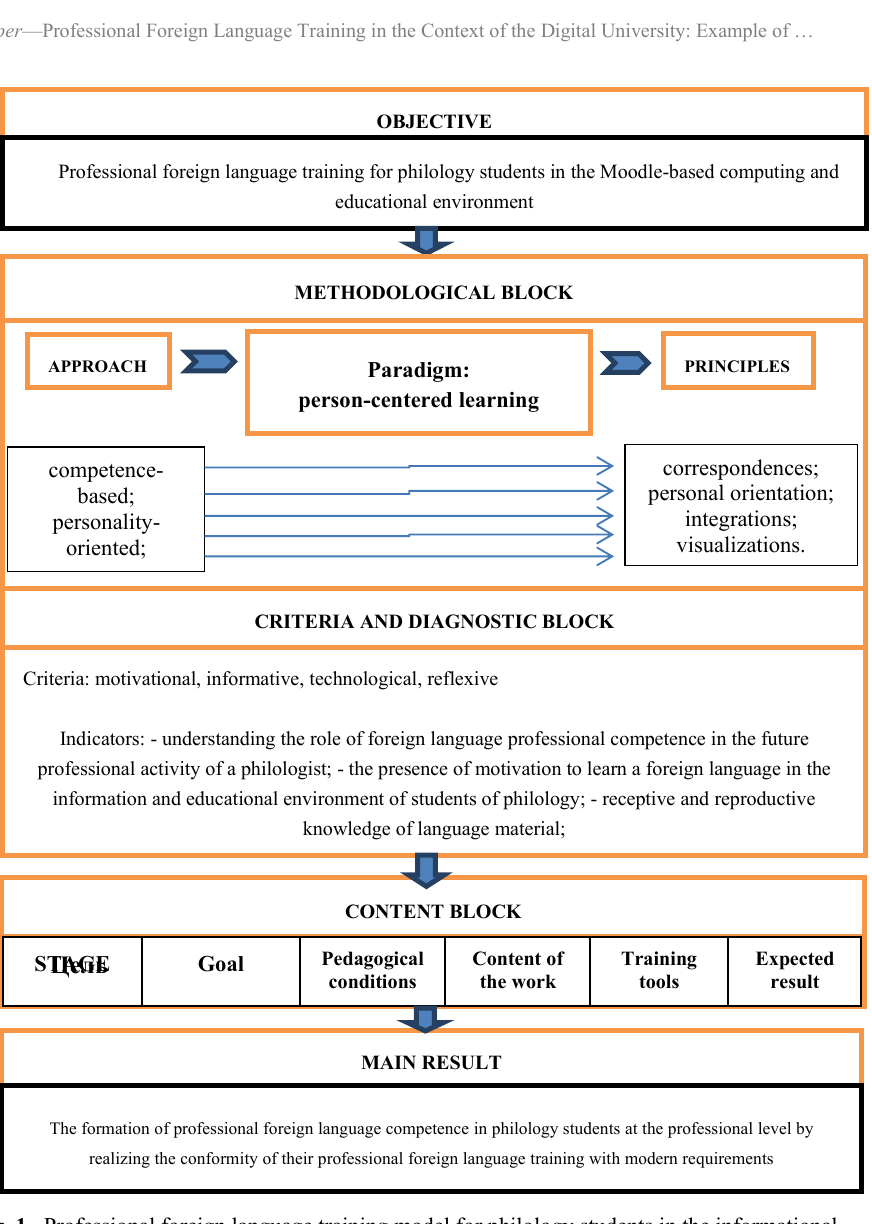
Fig. 1. Professional foreign language training model for philology students in the informational and educational environment of the